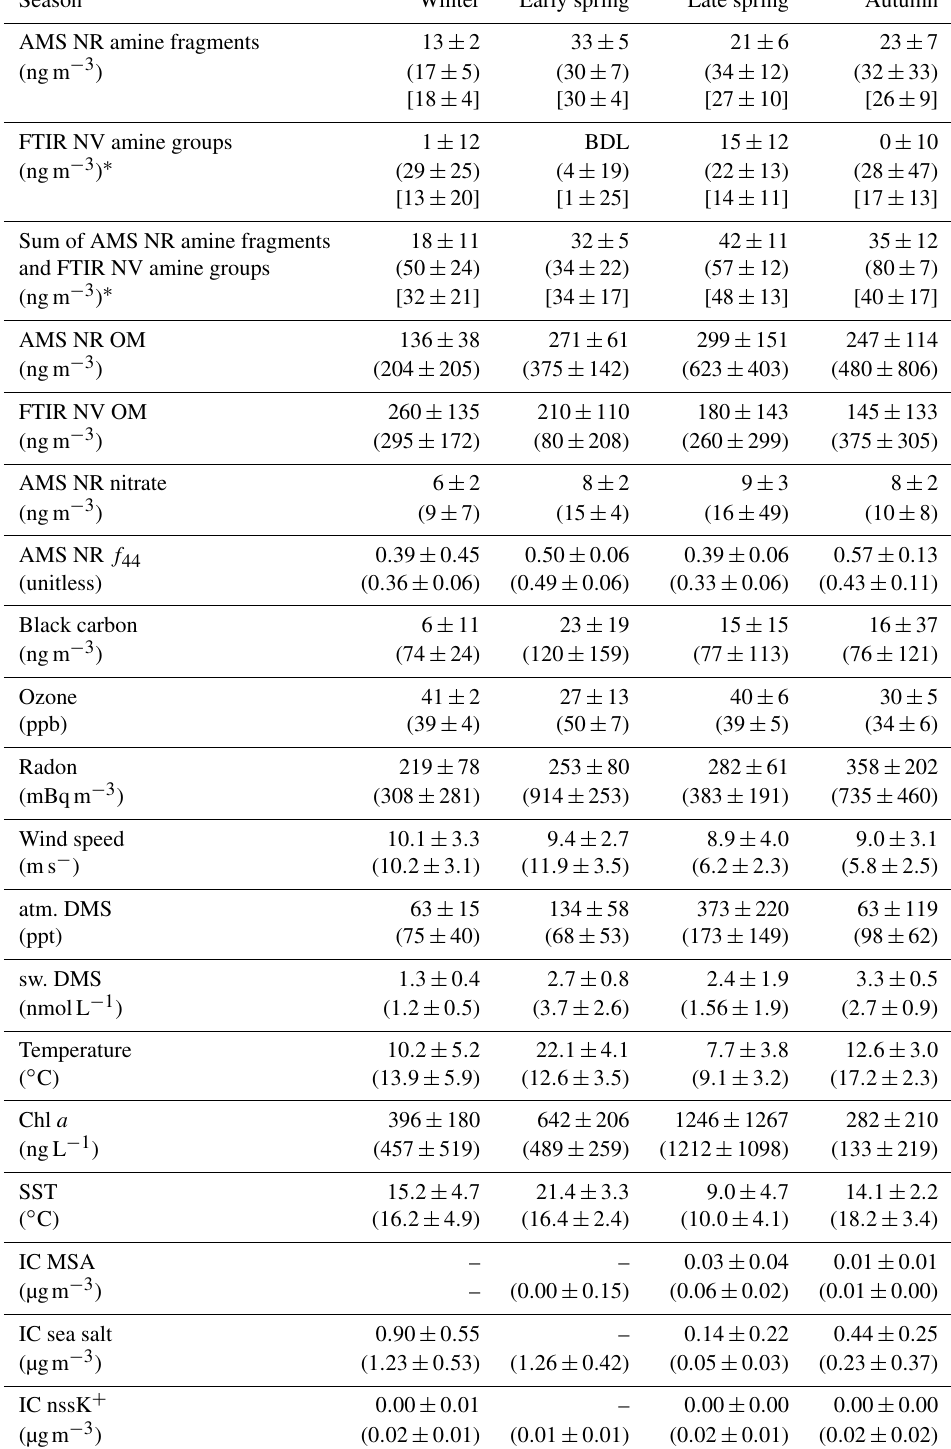
Table 3. Median concentrations and median absolute deviations of amine, tracer, and environmental measurements during NAAMES for marine (first line in each row) and continental (second line in each row, in parentheses) periods. Seasonal median concentrations and median absolute deviations are given in square brackets and were averaged over the sampling times of filters categorized as marine, continental, or